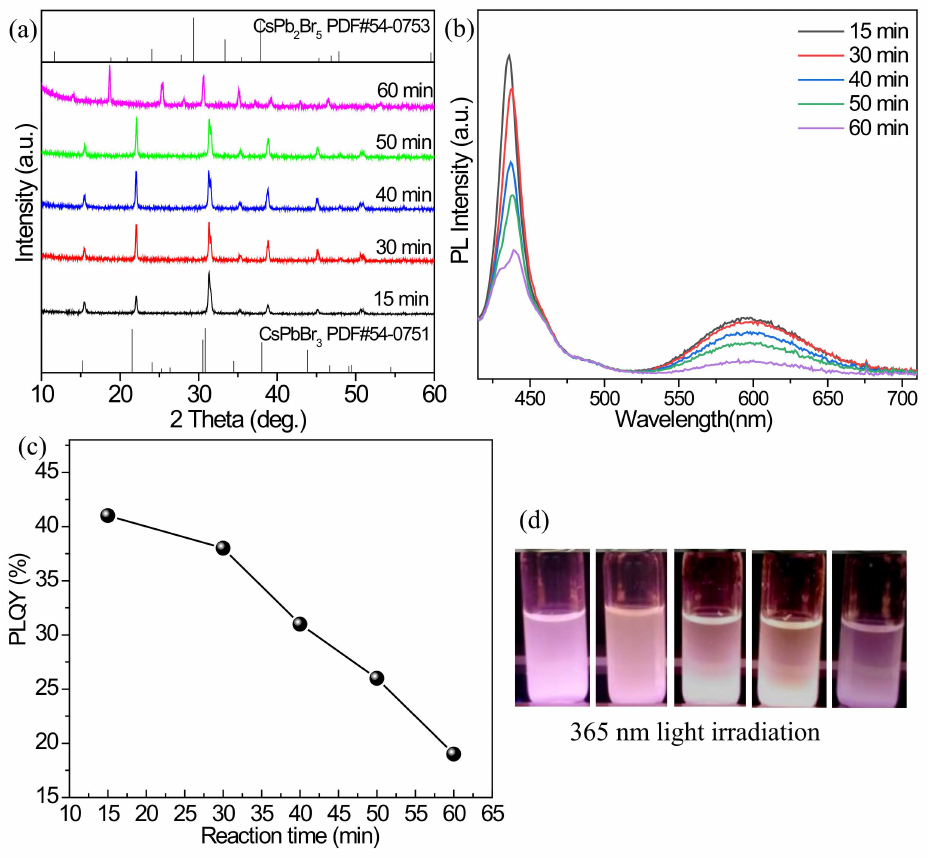
Figure 3. ( a ) XRD patterns, ( b ) PL emission spectra, and ( c ) PLQYs of the Mn 2+ -doped products fabricated with different reaction times. ( d ) Optical images of the cyclohexane solutions containing the Mn 2+ -doped products under the environment of 365 nm light: from left to right, the reaction times are 15, 30, 40, 50, and 60 min,